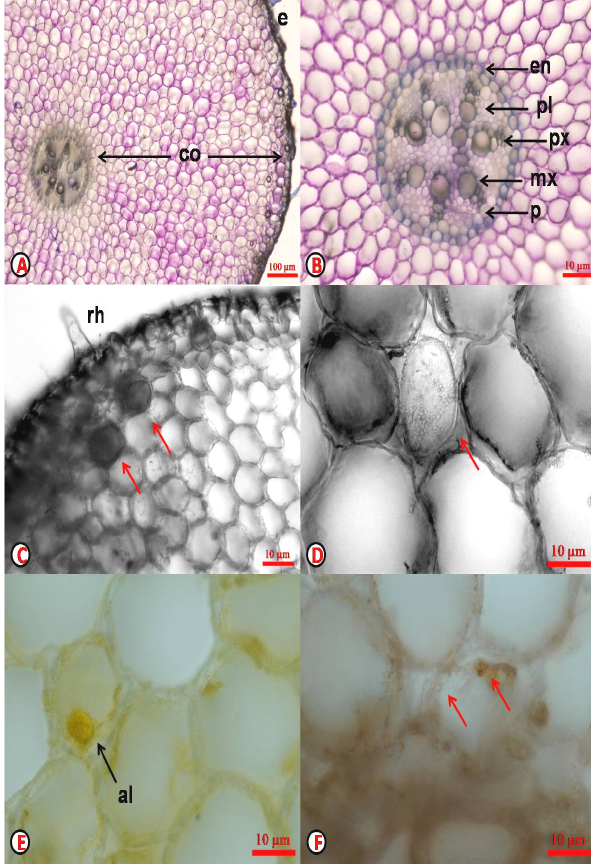
Fig. 4. Transversal section of Allium wallichii root: A) T.S. of showing the stele, cortex and epidermis of root; B) Magnified portion of the stele; C) A portion of a T.S. showing the presence of cells with mycorrhizal fungi (see arrows) near the root hair; D) Portion enlarged of C) showing the presence of mycorrhizal fungi; E) Presence of alkaloid (see arrow) treated with Dragondroff’s reagent; F) Presence of total lipid (see arrows) stained with Sudan III; al - alkaloid; co - cortex; e- epidermis; en - endodermis; mx - metaxylem; p - pericycle; pl - phloem; px - protoxylem; rh - root hair.